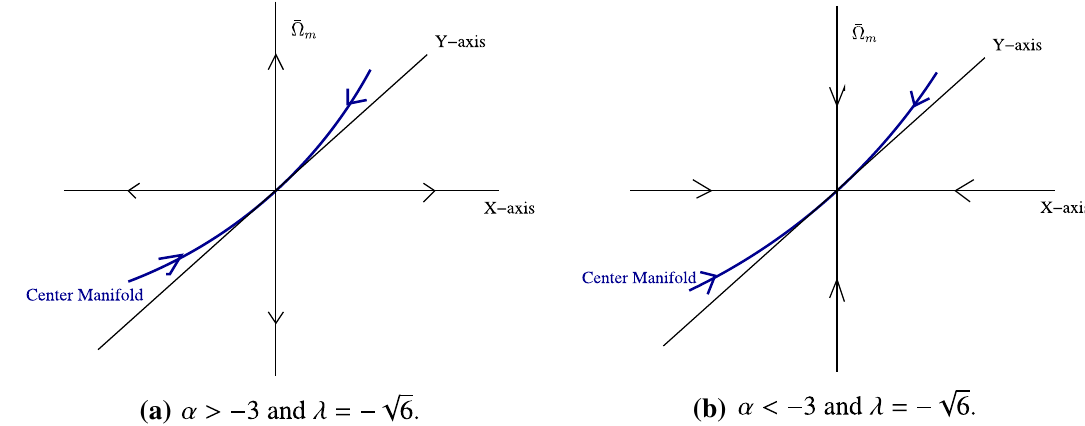
−√ 6. All center manifolds (blue curves) lie on (X-Y)-plane